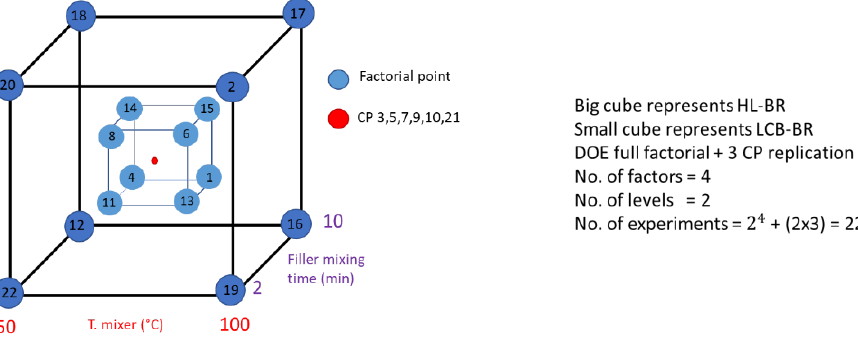
Figure 1. Two-level full factorial design of the experiment (DOE) setup with the center point .